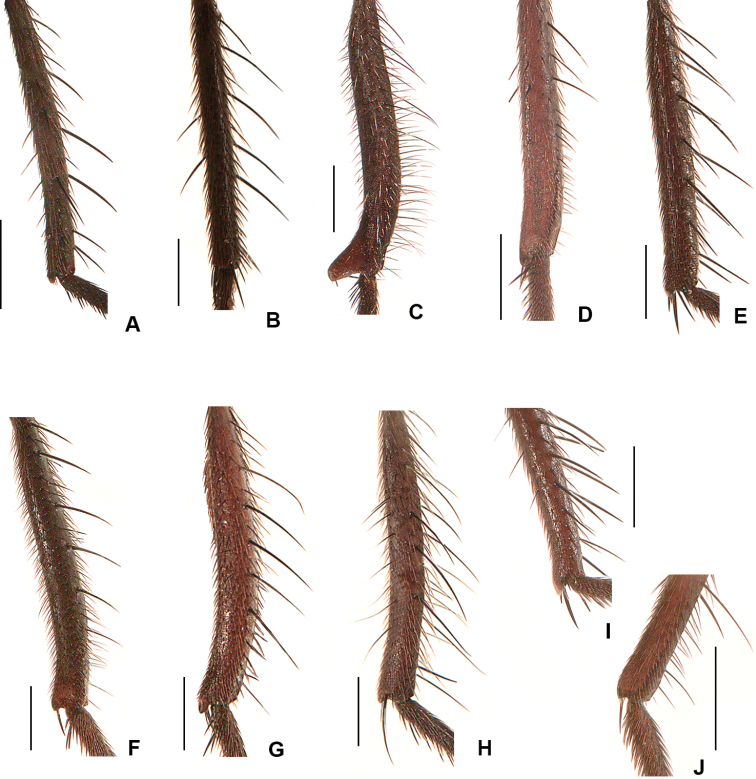
Male hind tibia, dorsal view AD.
pontiBD.
aterrimaCD.
groenlandicaDD.
setibasisED.
similisFD.
vockerothiGD.
quadrisetosaHD.
glacialisID.
huckettiJD.
woodorum. Scale bars: 0.5 mm.